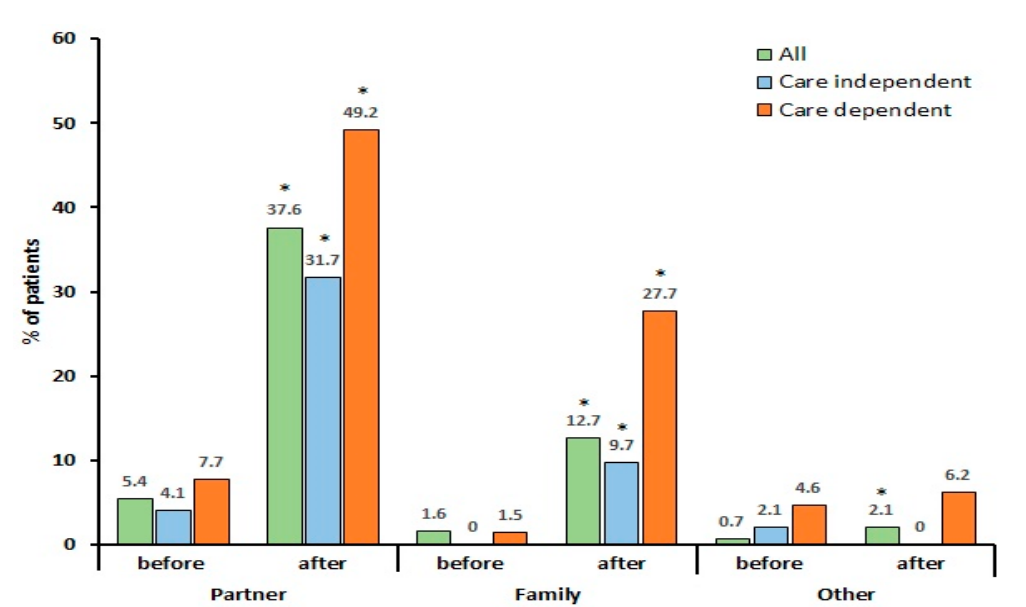
Figure 1. Need for help with personal care before and after coronavirus disease 2019. * p < 0.05 versus before infection based on the McNemar test. All ( n = 1837); care-dependent: Care Dependency Scale (CDS) score ≤ 68 points ( n = 65); care independent: CDS score > 69 points ( n = 145).